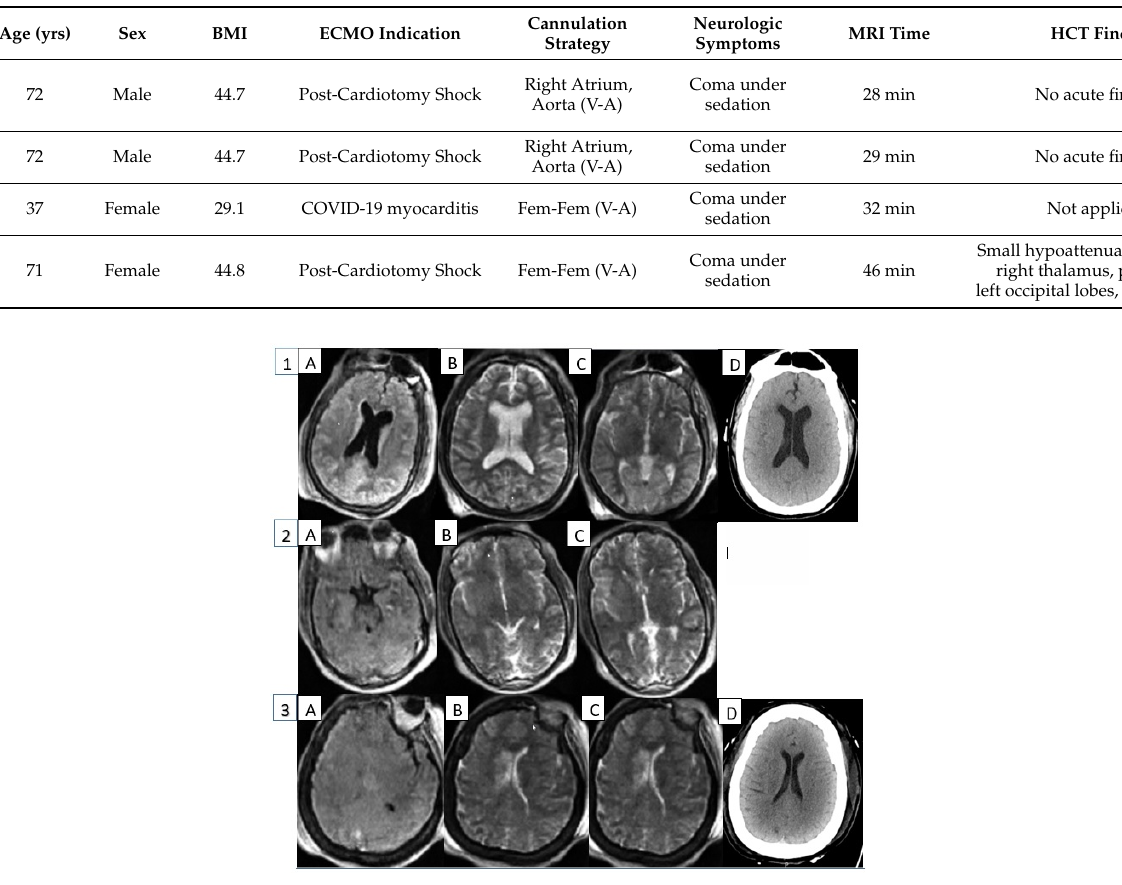
Figure 3. Point-of-care MRI and comparative HCT images. Representative point-of-care MRI im- ages of three critically ill patients with an intra-aortic balloon pump (IABP). Panel ( A ) represents flair images, ( B ) and ( C ) are T2 sequences, and ( D ) represents comparative head computed tomog- raphy (CT) image when available. Patient 1 demonstrated periventricular white matter hypo-in- tensity concerning for chronic ischemic changes. Patient 2 demonstrated left focal cerebellar en- cephalomalacia with a right sided artifact from an ultrasound probe. No abnormalities were dis- covered in Patient